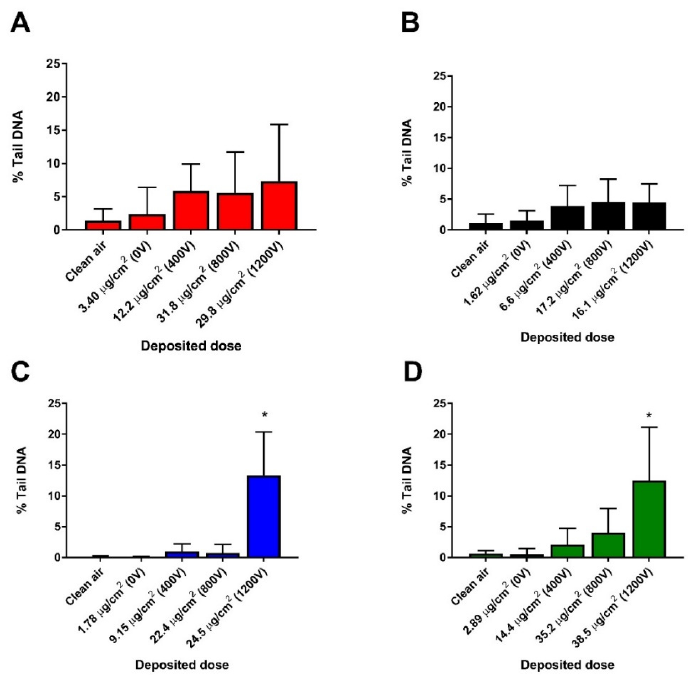
Figure 6. DNA damage measured in HBE cells after 4 h exposure to TiO 2 agglomerates at the ALI. 17 nm-SA ( A ), 17 nm-LA ( B ), 117 nm-SA ( C ), and 117 nm-LA ( D ). Data are expressed as means ± SD from two independent experiments with six replicates each. p < 0.05 (*) represent significant difference compared to control (One-way ANOVA followed by Dunnett’s multiple comparison test).